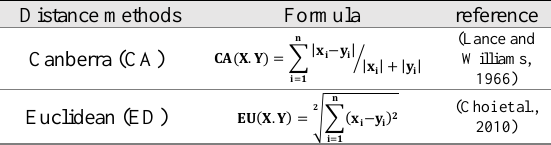
Table 3. Distance-based algorithm.